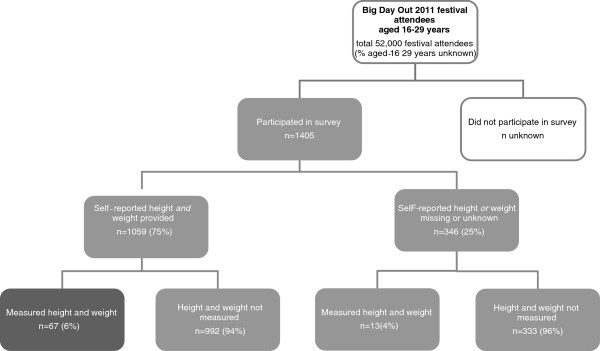
Representation of participant recruitment for survey and independent measurement. Final sample depicted in dark grey.